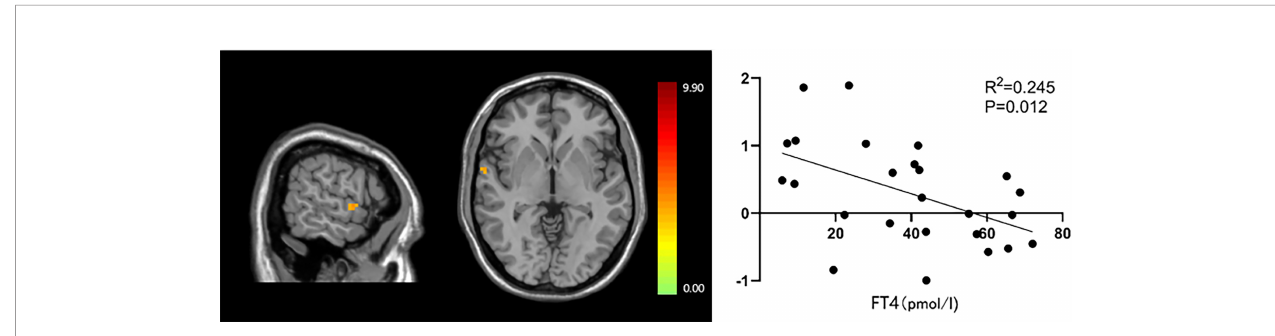
FIGURE 3 | The signi fi cant correlation between functional connections in the right superior temporal gyrus and FT4